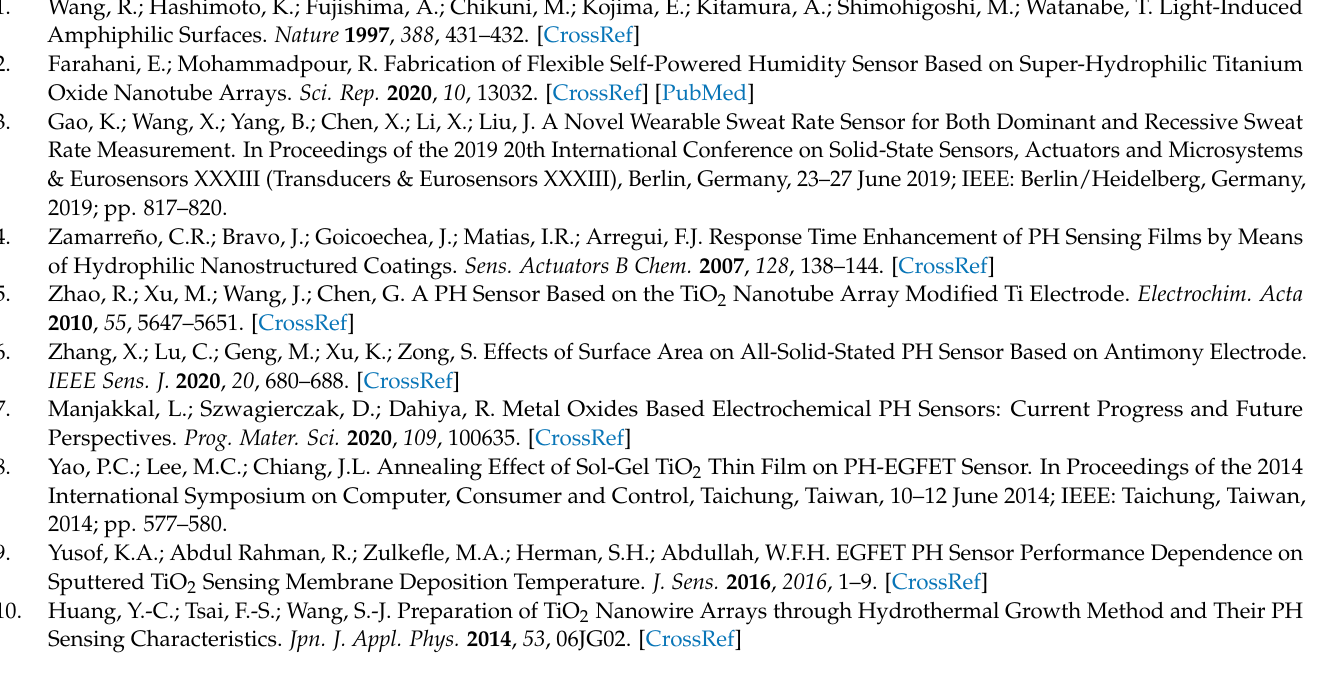
of pores and ridges. Figure S4: One µ L water droplet contact angle measurements on the electrodes obtained with different fabrication parameters. Table S1: The atomic ratios and parameters of the deconvoluted XPS spectra for different electrodes. Table S2: Sensitivity of the electrodes treated with different fabrication parameters. Table S3. Comparation of the sensitivity and CA of the electrodes before and after